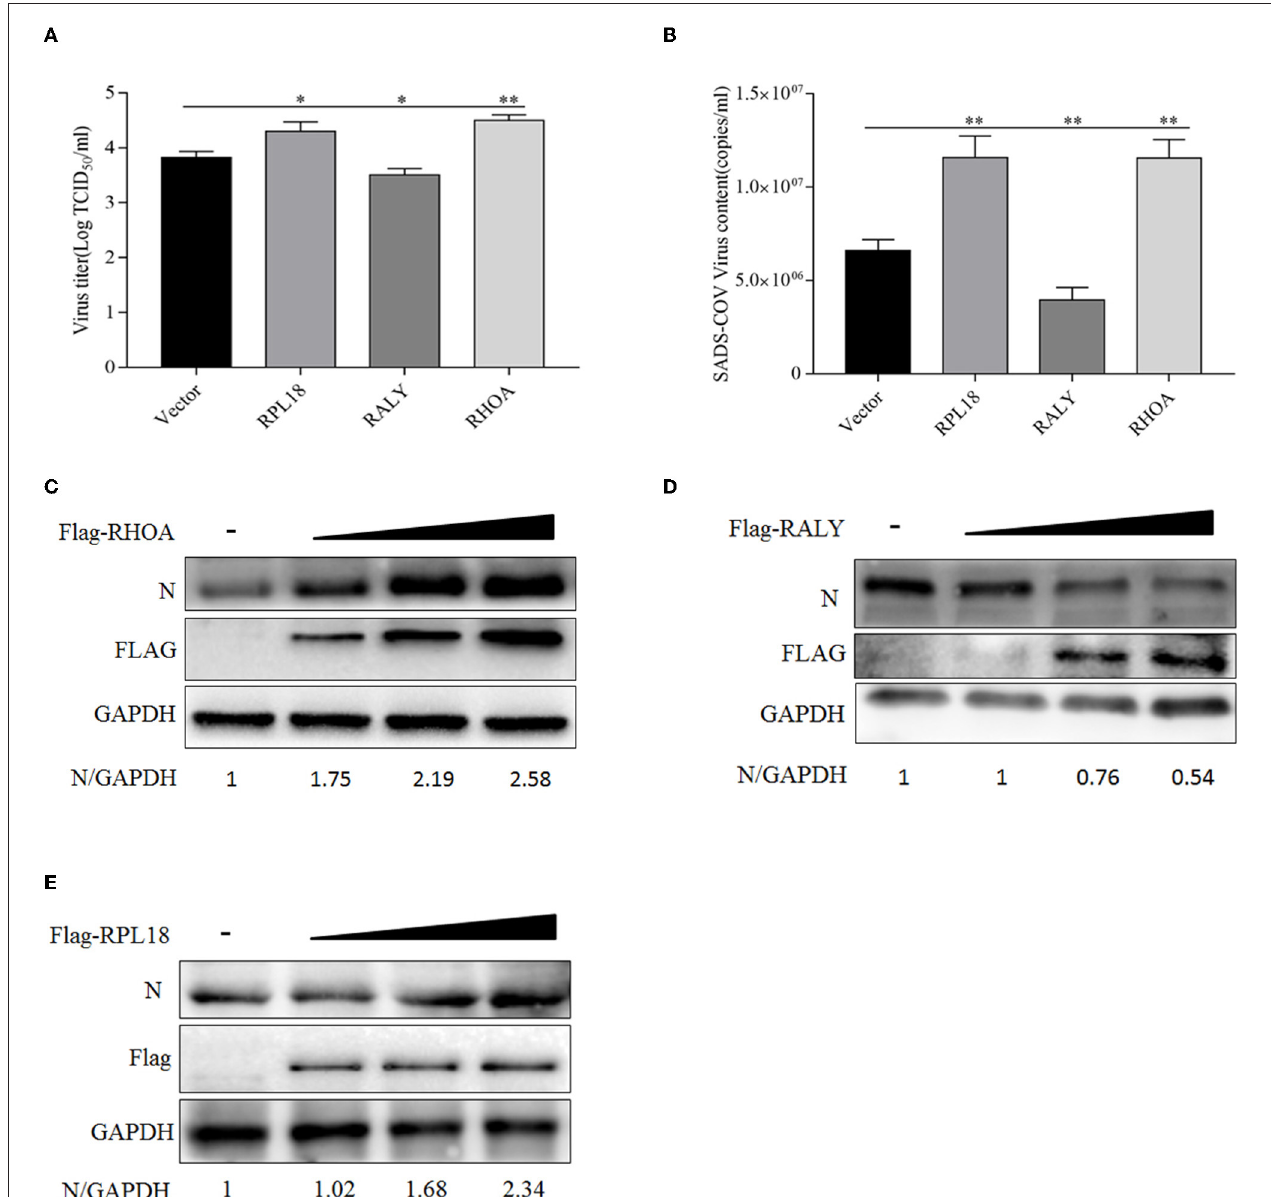
FIGURE 6 | Overexpression of host proteins RPL18, RALY, and RHOA affects swine acute diarrhea syndrome coronavirus (SADS-COV) replication. (A) When the Vero cells were laid on 12-well plates, and the confluence degree reached 80%, empty vector (4 µ g/well), Flag-RPL18 (4 µ g/well), Flag-RALY (4 µ g/well), and Flag-RHOA (4 µ g/well) were transfected into the cells. At 24h after transfection, 1 multiplicity of infection (MOI) dose of SADS-COV was added to the cell. Viral titers were detected by TCID50 at 36 hpi. (B) Sample treatment as described in (A) . After 36 hpi, the samples were collected by RNAiso Plus, and the total RNA was extracted. The mRNA expression level of SADS-CoV N gene was evaluated by real-time RT-qPCR. Flag-RHOA (C) , Flag-RALY (D) , and Flag-RPL18 (E) were transfected into Vero cells at different doses (1, 2l, and 4 µ g/well) with empty vector, and the rest were treated as described in (A) . N protein expression was detected by Western blotting at 36 hpi. GAPDH was used as an internal loading control. The band densitometry was analyzed by Image J software. All data are presented as means ± SD and were analyzed by GraphPad Prism software (GraphPad Software, San Diego, CA, USA) using a t -test (*0.05 < p < 0.01, ** p < 0.01). (NDV), rice stripe virus (RSV), and Ebola virus and uses this the translation initiation factor eIF3, which was required for interaction to affect virus replication (Spurgers et al., 2010; translational transactivation of CaMV (Leh et al., 2000; Bureau Li et al., 2018; Duan et al., 2021). RPL18 of Arabidopsis et al., 2004). RPL18 forms complexes with infectious thaliana interacted with P6 of cauliflower mosaic virus (CaMV) in a complex consisting of several ribosomal proteins and